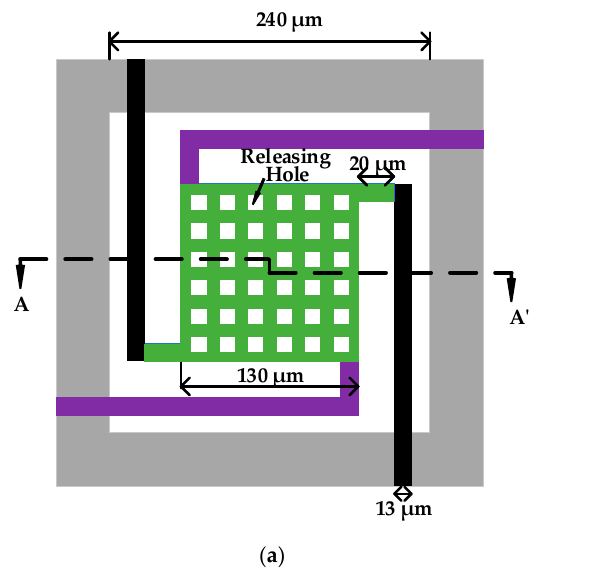
Figure 4. Schematic diagram of Pirani gauge readout circuit.